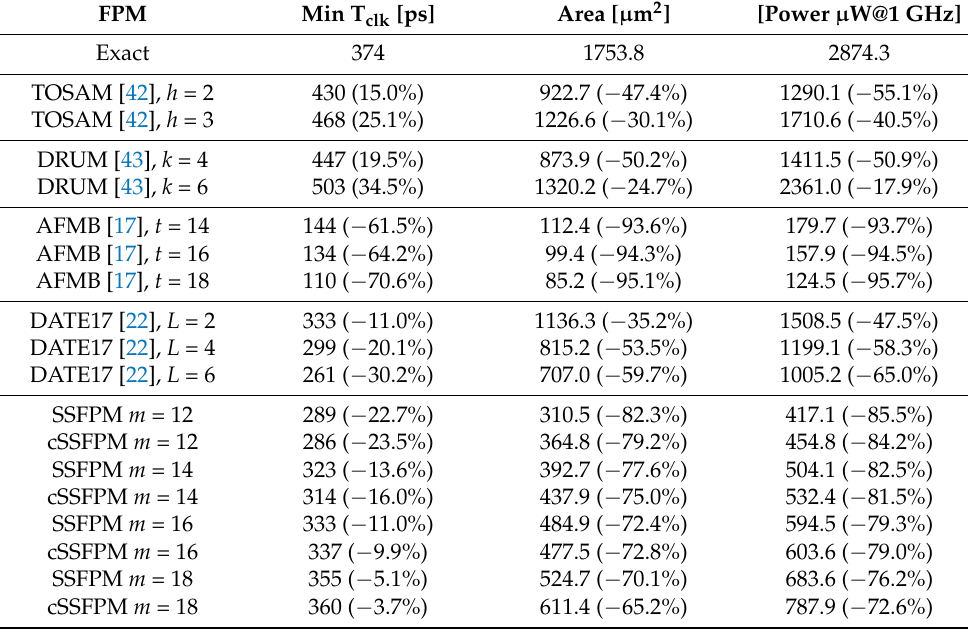
Table 3. Hardware performances of the proposed SSFPM and cSSFPM, and the state-of-the-art. FPM Min T clk [ps] Area [ µ m 2 ] [Power µ W@1 GHz]